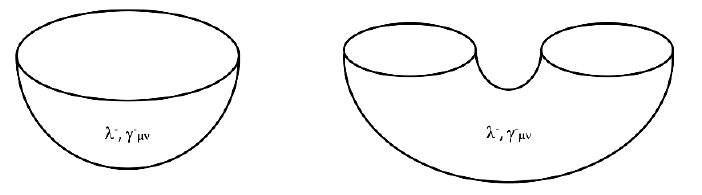
Figure 1 . Two euclidean path integral states with sources prepared on manifolds of di(cid:11)erent topology (the hemisphere and the cylinder). On the left, the state lives in a single copy of the CFT Hilbert space H while on the right, it lives in H (cid:2) H